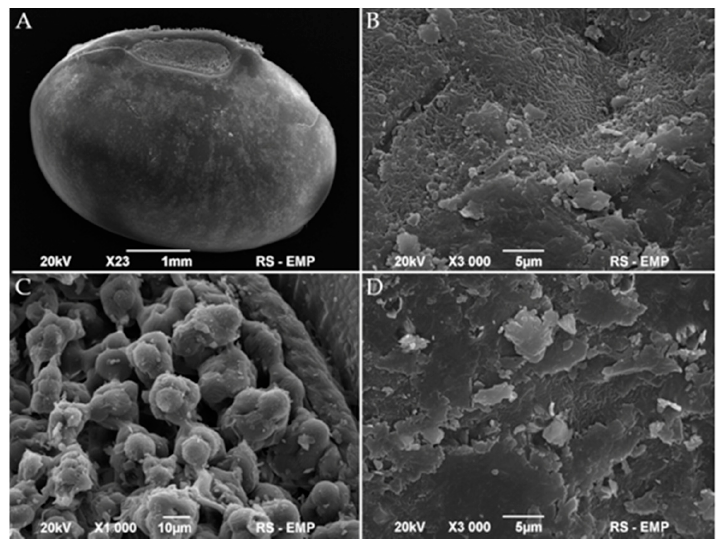
Figure 2. Scanning electron micrographs of whole native bean ( A ), hilum ( C ), and coat ( B , D ) of mung bean.